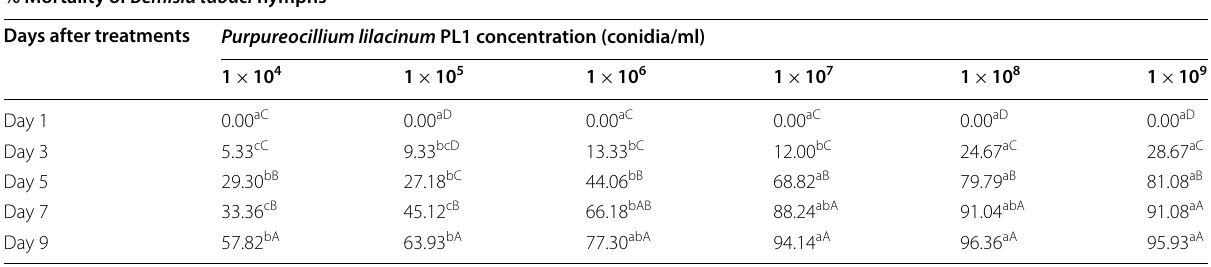
Different superscript lowercase letters (a–c) within a line and capital letters (A–D) within a column indicate statistically significant differences between groups ( p < 0.05)